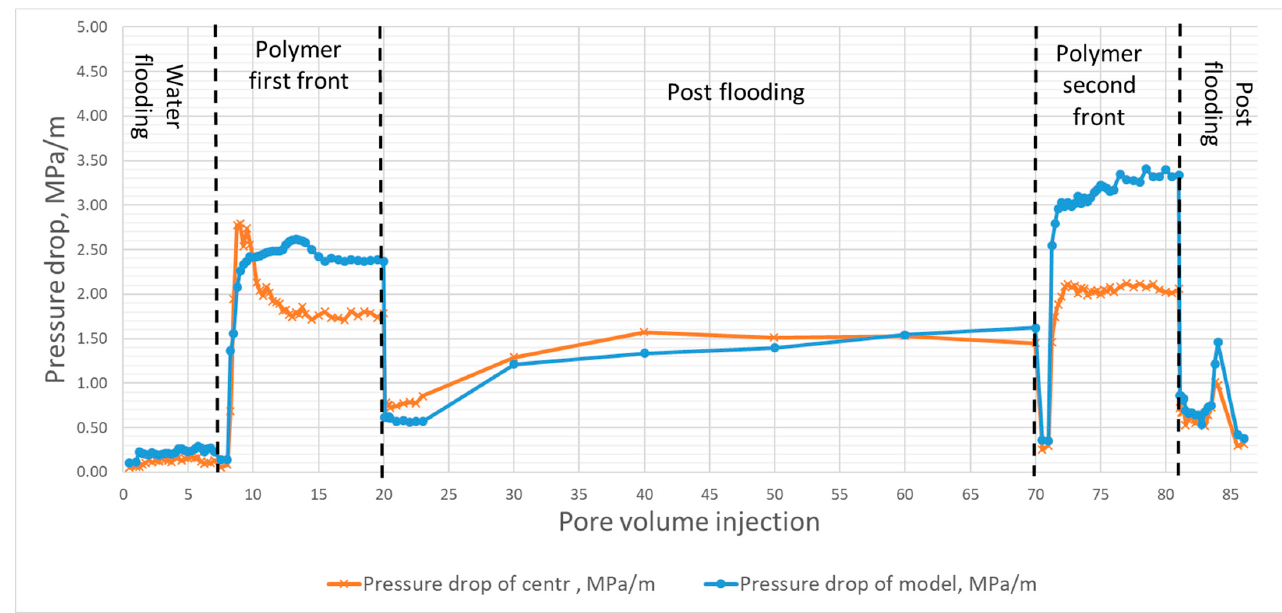
Figure 6. Pressure drops and polymer concentration changes during experiment No. 6 (core 1229 md, 0.01 Pa · s at 7.3 s − 1 shear rate) as a function of pore volume injected (PV). A bump is noticed for pressure during the first polymer front (orange curve with the cross symbols or Grad center) which corresponds to a little volume of oil displaced by polymer, considered for the rest of the study.